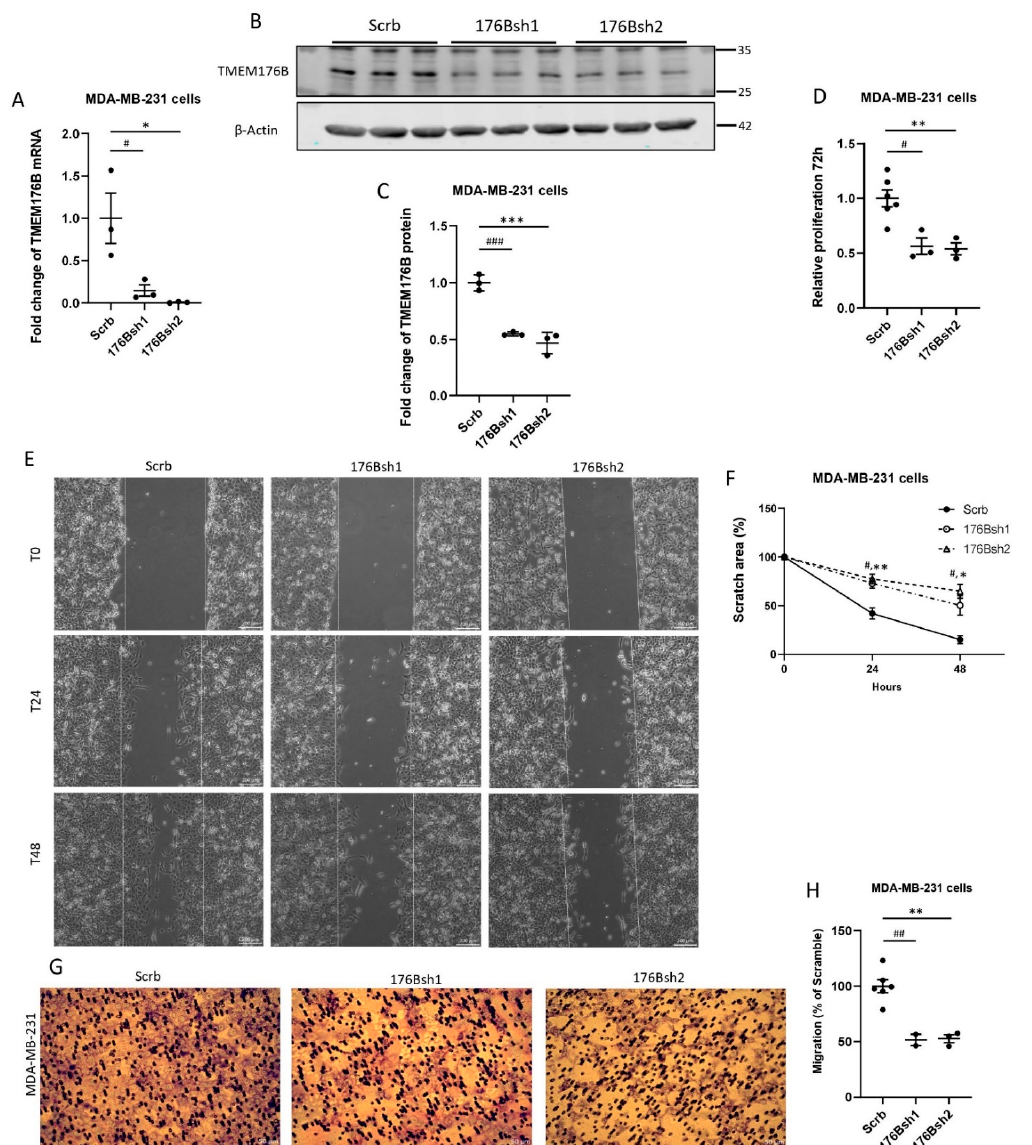
Figure 1. TMEM176B knockdown decreased the proliferation, wound healing, and the migration of MDA-MB-231 cells in vitro. ( A ) TMEM176B mRNA expression was assessed by qRT-PCR in control (Scrb) and TMEM176B-silenced (176Bsh1, 176Bsh2) MDA-MB-231 cells. (n = 3 per group, with two independent experiments). ( B , C ) Western blot analysis examining TMEM176B expression in control and TMEM176B-silenced cells (n = 3 per group, with three independent experiments). ( D ) Results of proliferation assay for control and TMEM176B-silenced cells grown for 72 h (n = 6 for Scrb; n = 3 for 176Bsh1 and 176Bsh2 per group, with three independent experiments). ( E ) Representative images of wound healing assay. Images were taken at time points T0 (0 h), T24 (24 h), and T48 (48 h) after performing the scratch at the same coordinates for each image. Scale bars: 200 μ m. ( F ) Quantification of wound healing assay. “Scratch area %” indicates the percent of area remaining compared with time 0. (n = 3 per group, with two independent experiments). ( G ) Representative images of transwell migration assay after 20 h, stained with Giemsa solution. Scale bars, 50 µ m. ( H ) Quantification of transwell migration assay. Stained area is expressed as a percent of control (Scrb) cells. (n = 6 for Scrb; n = 2 for 176Bsh1; n = 3 for 176Bsh2 per group, with two independent experiments). Data are presented as means ± SEM. Differences between groups were evaluated by the one-way ( A , C , D , F , H ) ANOVA test with the Bonferroni post hoc test. (# p < 0.05, ## p < 0.01, ### p < 0.001 between Scrb vs. 176Bsh1; * p < 0.05, ** p < 0.01, *** between Scrb vs. 176Bsh2) dataset (Supplementary Figure S1B) [28], and in histological grade 3 breast cancer compared with lower-grade breast cancers (Supplementary Figure S1C) [29]. High TMEM176B mRNA expression was also associated with decreased relapse-free survival in a majority of breast cancer studies examined (Supplementary Figure S1D–F)